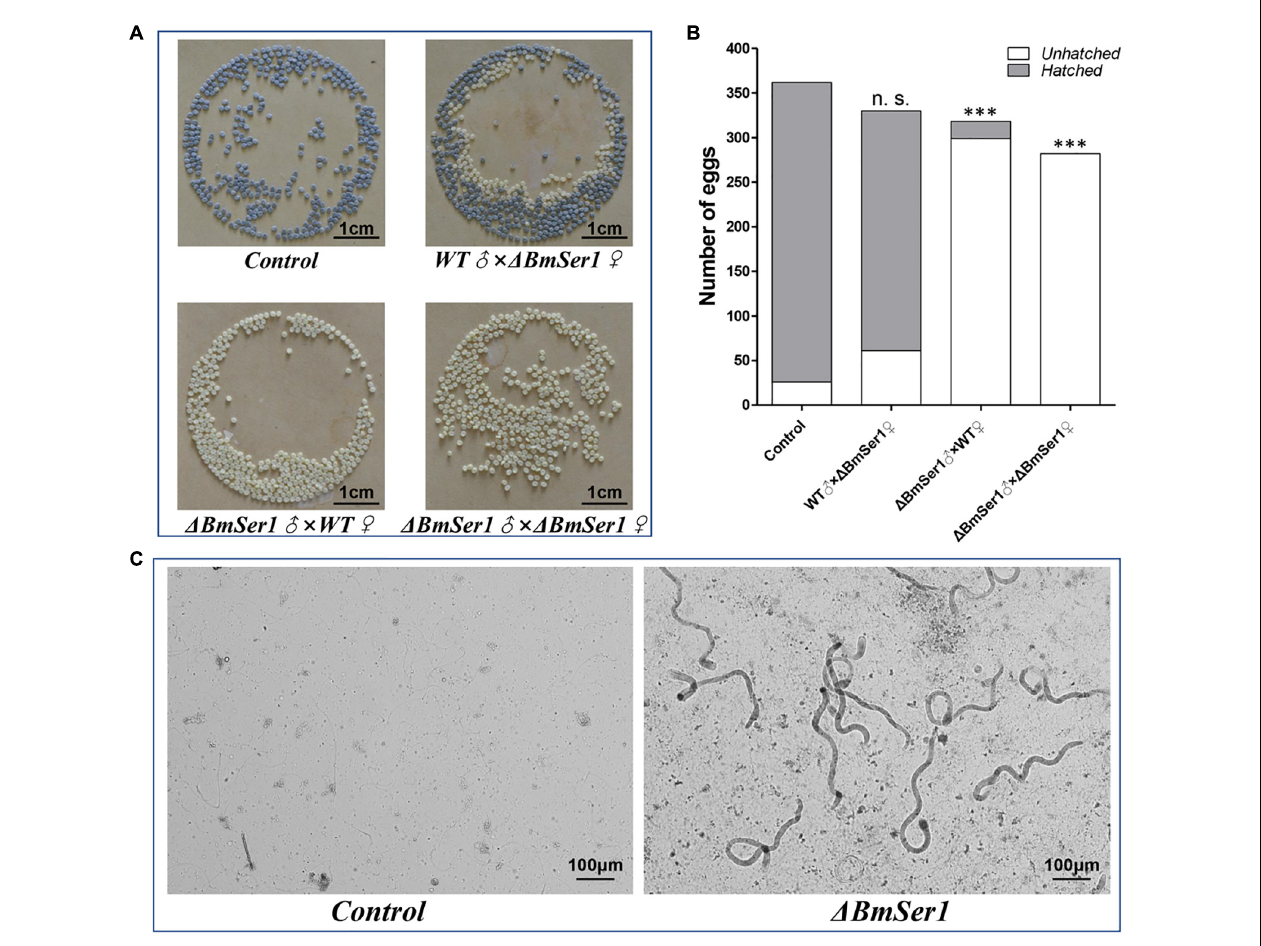
FIGURE 4 | BmSer1 mutations result in male sterility. (A) Photographs of eggs produced by different crosses. (B) Plot of the number of eggs hatched (gray) and unhatched (white) resulting from different crosses. (C) Morphologies of sperm in bursa copulatrix from representative control mating and from a representative WT female mated with (cid:49) BmSer1 mutant male. The data shown are means ± SEM ( n = 30 pairs per group). Asterisks indicate significant differences with a two-tailed t -test: ∗∗∗ P < 0.001, n.s. not